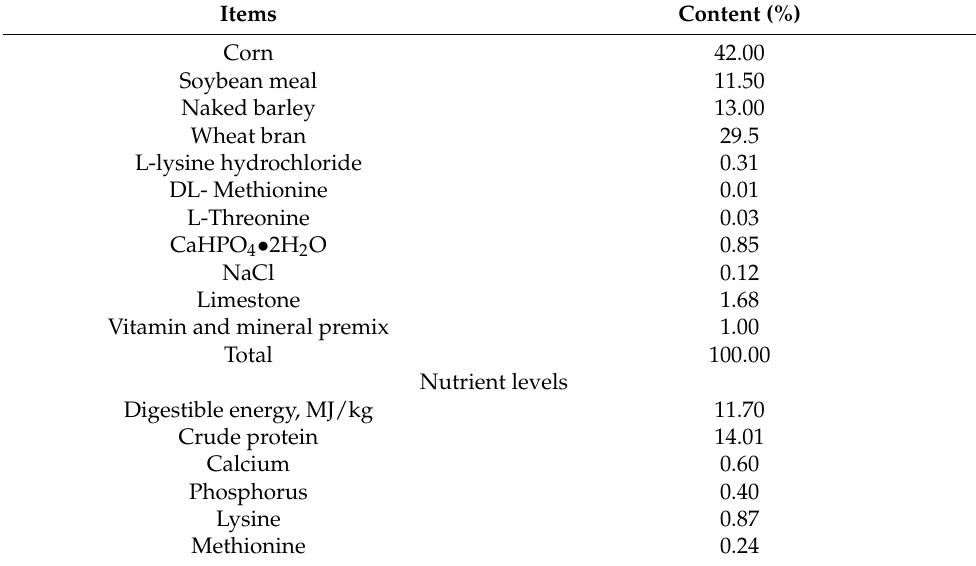
Table 1. Composition and nutrient levels of basal diets (%, as-fed